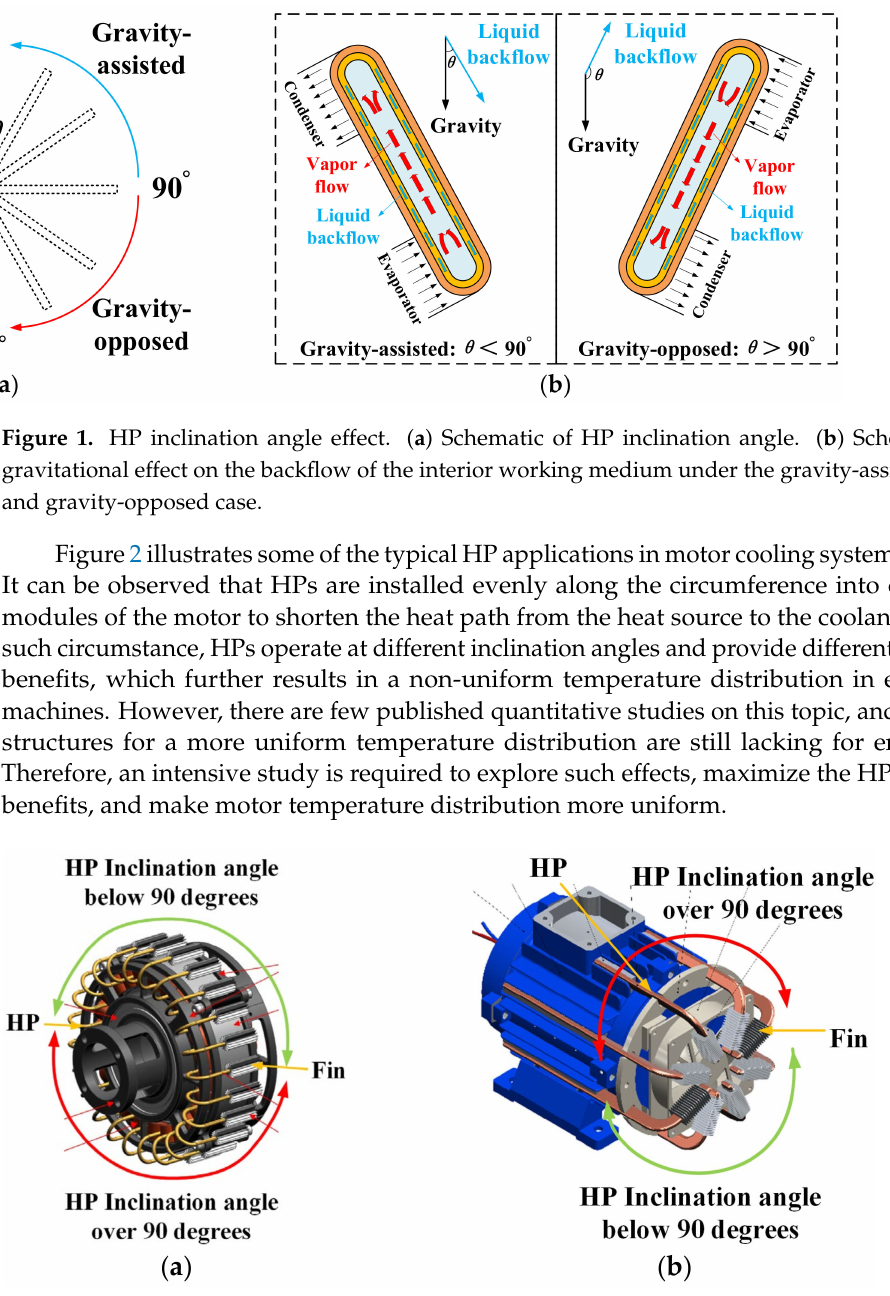
Figure 2. HP applications in electrical machines at different inclination angles. ( a ) A cooling system with HPs inserted into the windings [23]. ( b ) A cooling structure with HPs mounted in the casing